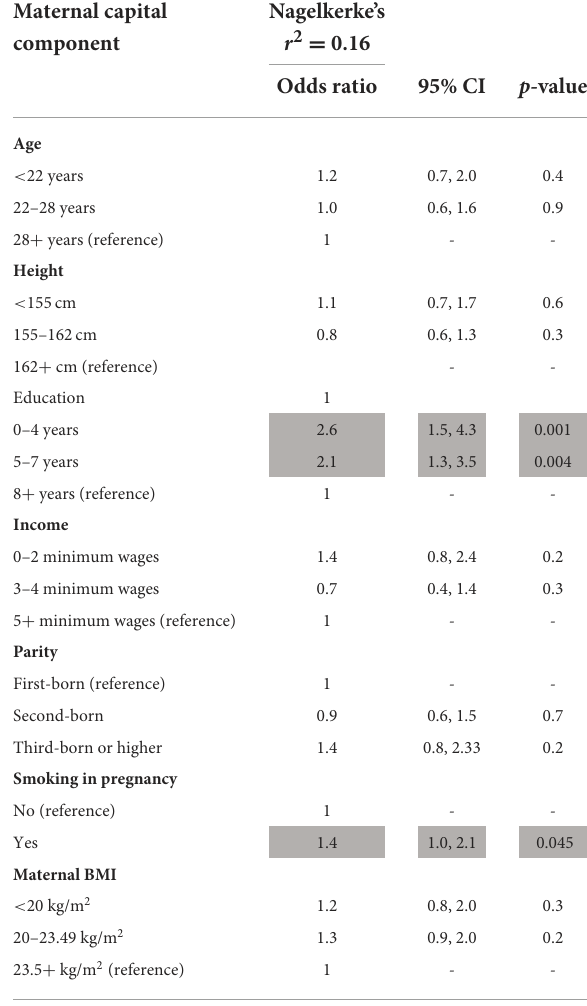
TABLE 1 Reasons for sons not studying ( n = 420), stratified by their reproduction status at 18 years.